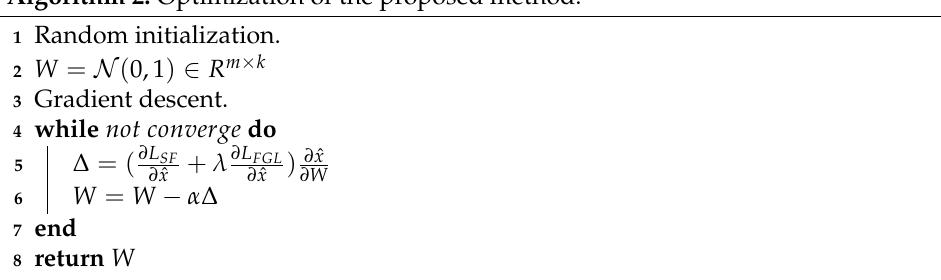
Algorithm 2: Optimization of the proposed